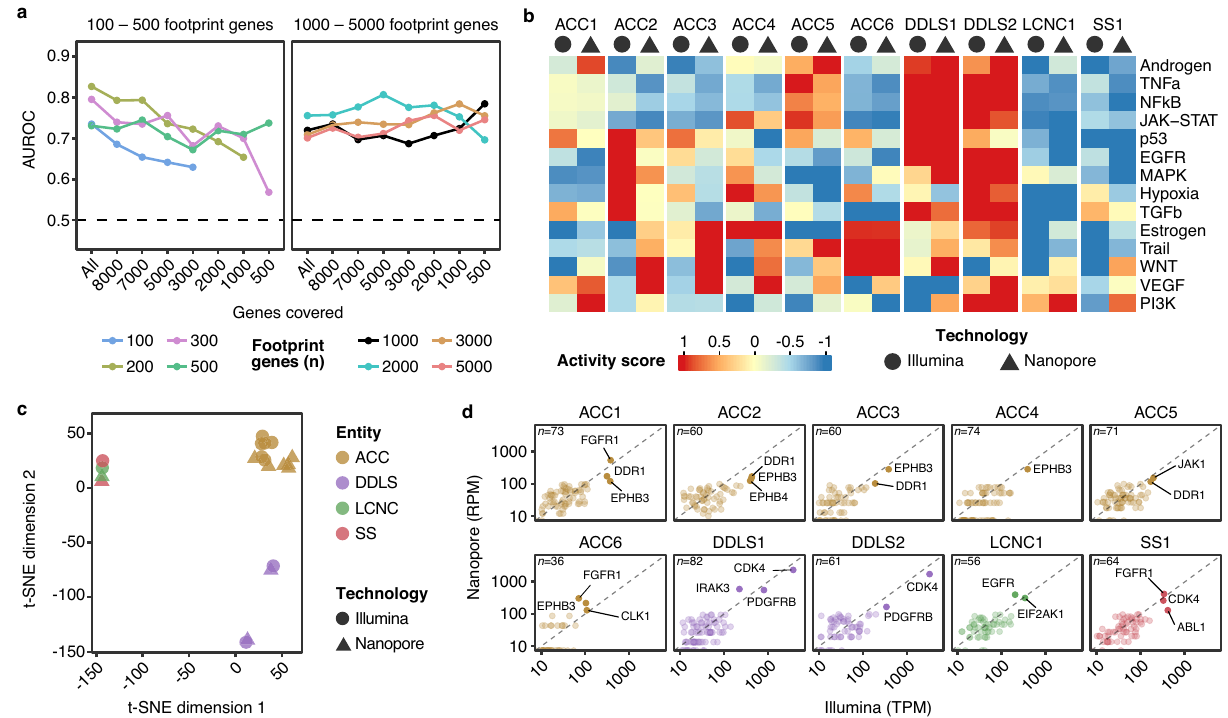
Figure 2. Analysis of pathway activities and kinase expression. ( a ) Performance of PROGENy on nanopore RNA-seq data using different numbers of footprint genes per pathway according to gene coverage. ( b ) Activities of 14 signaling pathways (rows) in ten tumor samples (columns) determined by nanopore (triangle) and Illumina (circle) RNA-seq. ( c ) Clustering of samples based on pathway activation scores shown in panel b after dimensionality reduction with t-distributed stochastic neighbor embedding (t-SNE). ( d ) Correlation of expression of kinases in the target spectrum of clinically approved inhibitors determined by nanopore and Illumina RNA-seq. For each sample, the most highly expressed kinases are